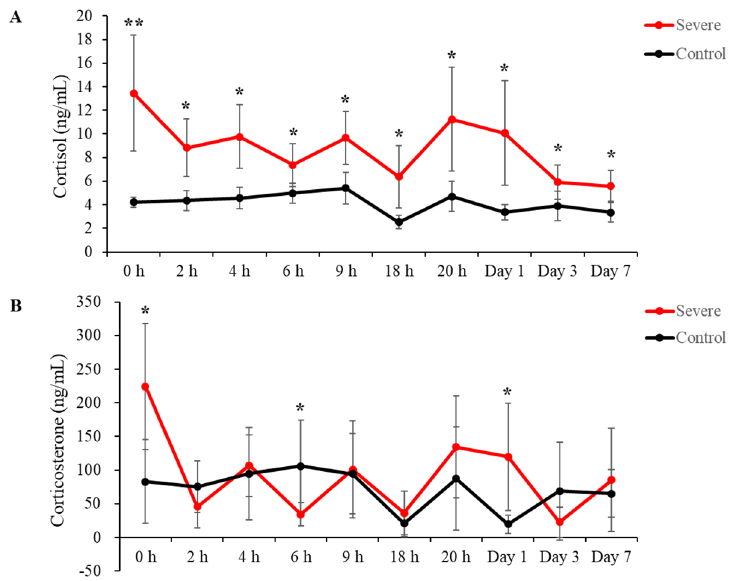
Figure 1. The hypothalamic-pituitary-adrenal (HPA) axis was influenced by acute severe stress. ( A ) Changes in cortisol concentrations induced by acute severe stress. ( B ) Alterations in corticosterone caused by acute severe stress. All data are expressed as means ±SD; * p < 0.05 and ** p < 0.001, n = 6 per group.